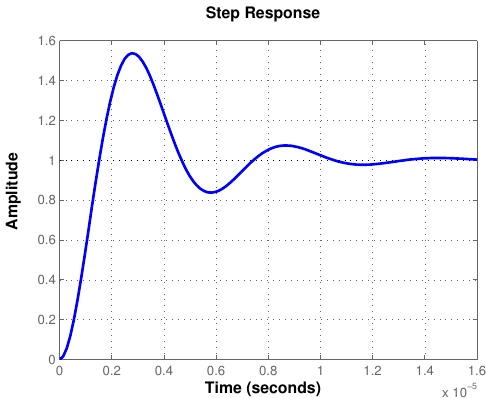
Figure 7. Step response of the closed-loop transfer function of a Buck converter by using the approximation of the fractional-order PID controller (14).